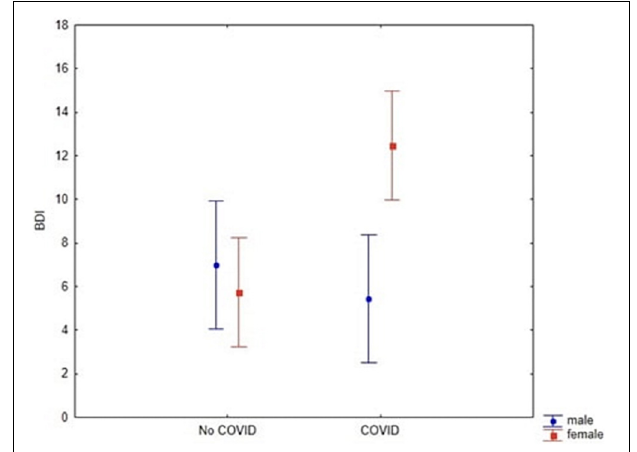
FIGURE 6 | Interaction between Gender and Diagnosis ( F = 3.05, p = 0.08) through IVAS scores. Vertical bars denote 0.95 confidence intervals.